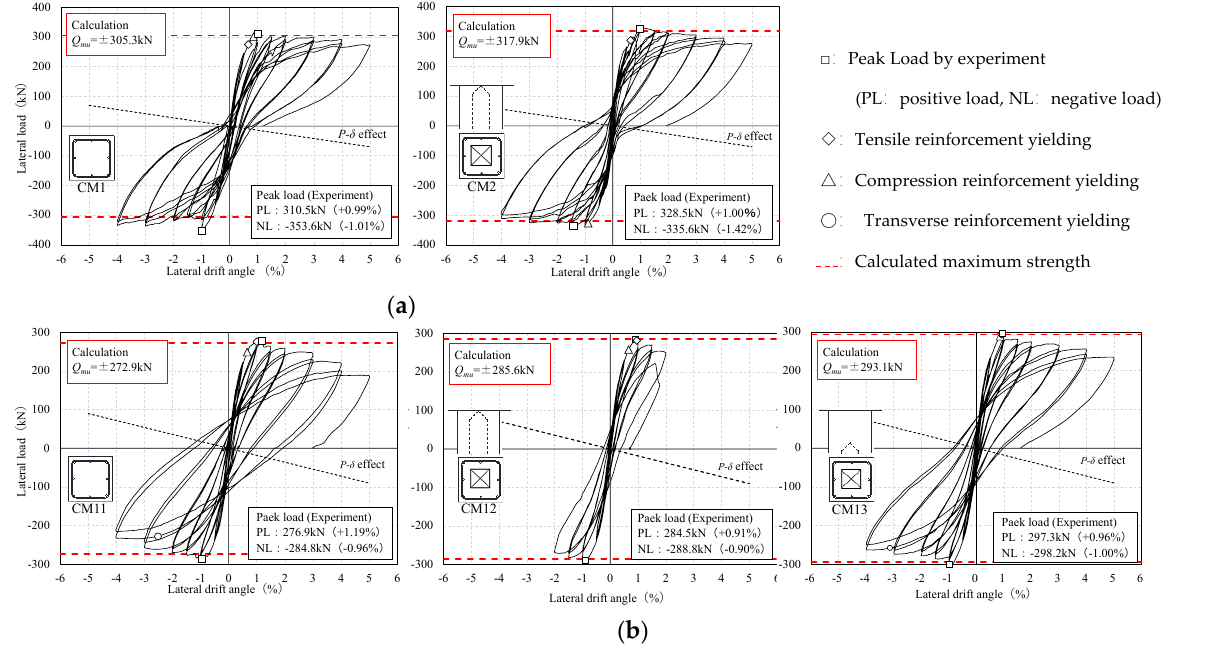
Figure 6. Hysteresis curves: ( a ) N-series; ( b ) S-series.